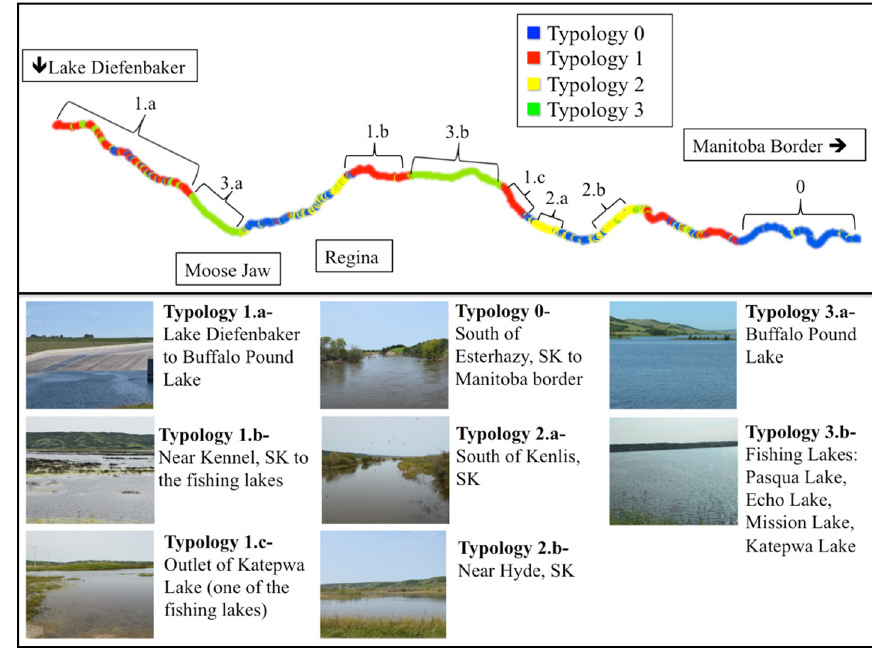
Figure 3. Delineated Typologies on the Qu’Appelle River centerline, key reaches labeled, site pictures corresponding to the key reaches.